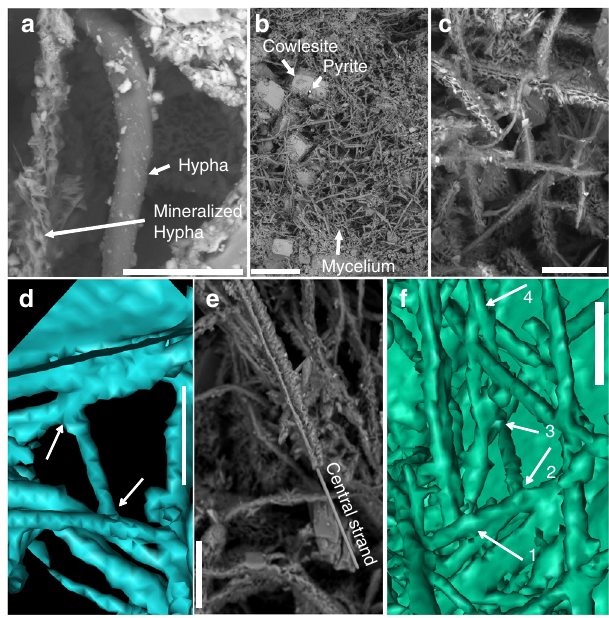
Fig. 1 Hypha characteristics. Back-scattered Environmental Scanning Electron Microscopy ESEM-images ( a – c , e ) and Synchrotron Radiation X-ray Tomographic Microscopy (SRXTM) surface renderings ( d , f ). ( a ) Organically preserved hypha (10 µ m in diameter) next to a mineralized hypha of the same diameter. ( b ) Mycelium like structures partly overgrowing cowlesite. ( c ) Branching and anastomosing mineralized hyphae. ( d ) Branching (T-junction) and anastomosing hyphae (indicated by arrows ). ( e ) Mineralized central strand in hyphae. ( f ) 3D-projection of the hyphae on the fracture surface, showing 1. Y-junction. 2. T-junction + anastomos. 3. Y-junction + anastomos. 4. Y-junction. Scale marker bars